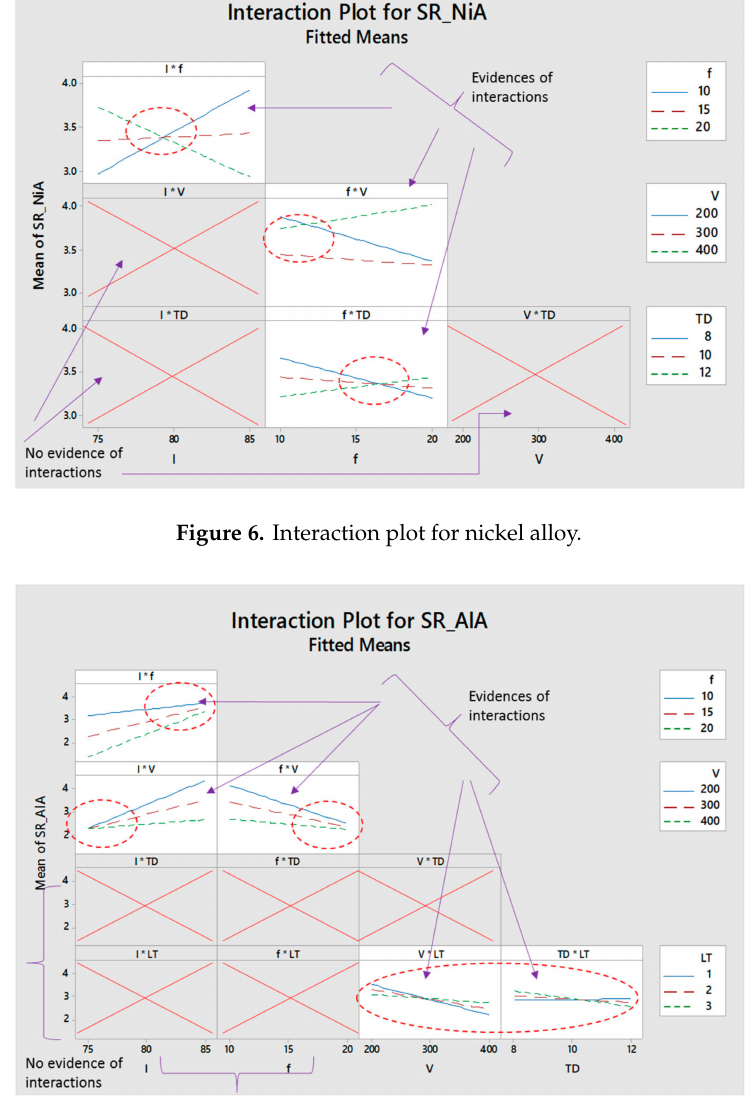
Figure 7. Interaction plot for aluminum